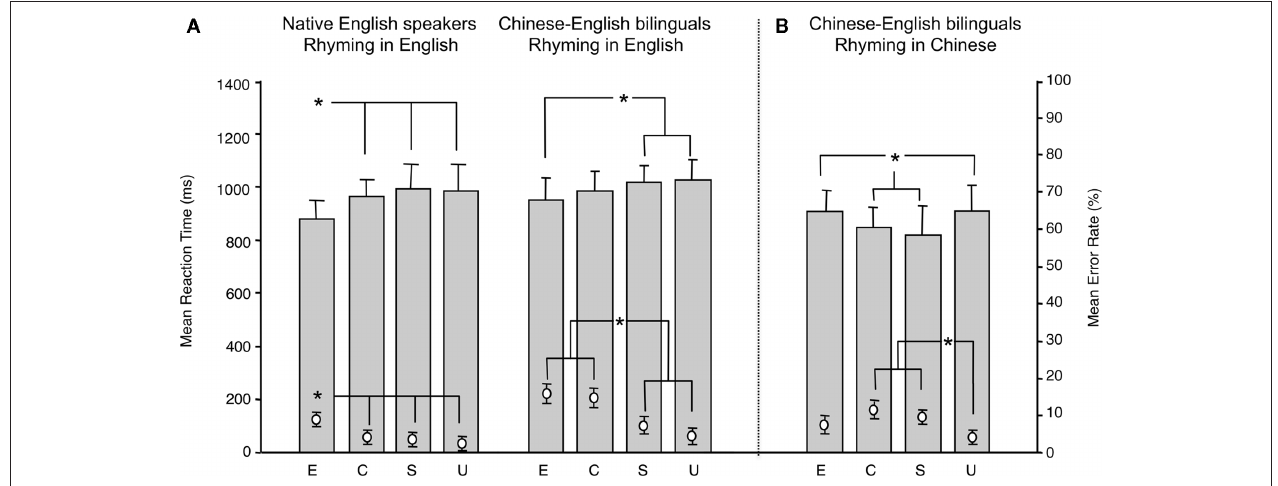
FiguRE 2 | Behavioral results of all groups in the rhyming judgment tasks. Reaction times (bars; left axis) and error rates (bullets; right axis) for the native English speakers and the Chinese–English bilingual speakers (A) in the English rhyming judgment task is presented on the left of the vertical line. Results of the Chinese–English bilingual speakers in the Chinese rhyming